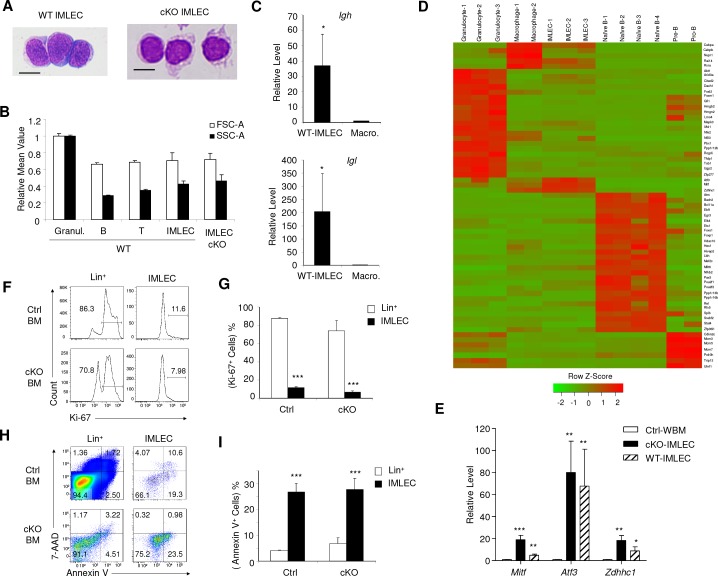
Comparison of IMLECs identified in both WT and Raptor-deficient BM.(A) Giemsa staining of Lin- CD11b+ PD-L1+ IMLECs from WT BM and Rptor-cKO BM. One representative result of 3 independent experiments is shown. Scale bar, 10 μm. (B) Size and granularity of IMLECs from Raptor Ctrl and cKo BM were evaluated by FSC and SSC, respectively. n = 5 for each group. (C) IMLEC from WT BM expresses sterile transcripts from the Igh and Igl loci. Ig transcript levels in macrophage are artificially defined as 1. (D) Heat map representing the relative expression levels for indicated population specific transcription factor genes. Genes up-regulated for at least 4-fold with FDR-adjusted p-value<0.01 were considered population-specific. (E) IMLECs from both WT and Raptor-cKO BM exhibit high levels of mRNA transcripts for the specified transcription factors (Mitf, Atf3 and Zdhhc1). n = 5 for each group. (F, G) Ctrl and cKO IMLECs are non-cycling cells in contrast to Lin+ BM cells. (H, I) IMLECs are prone to apoptosis based on their binding to Annexin V. Results in (C), (G) and (I) represent one of 2 independent experiments with each involving three mice per group.